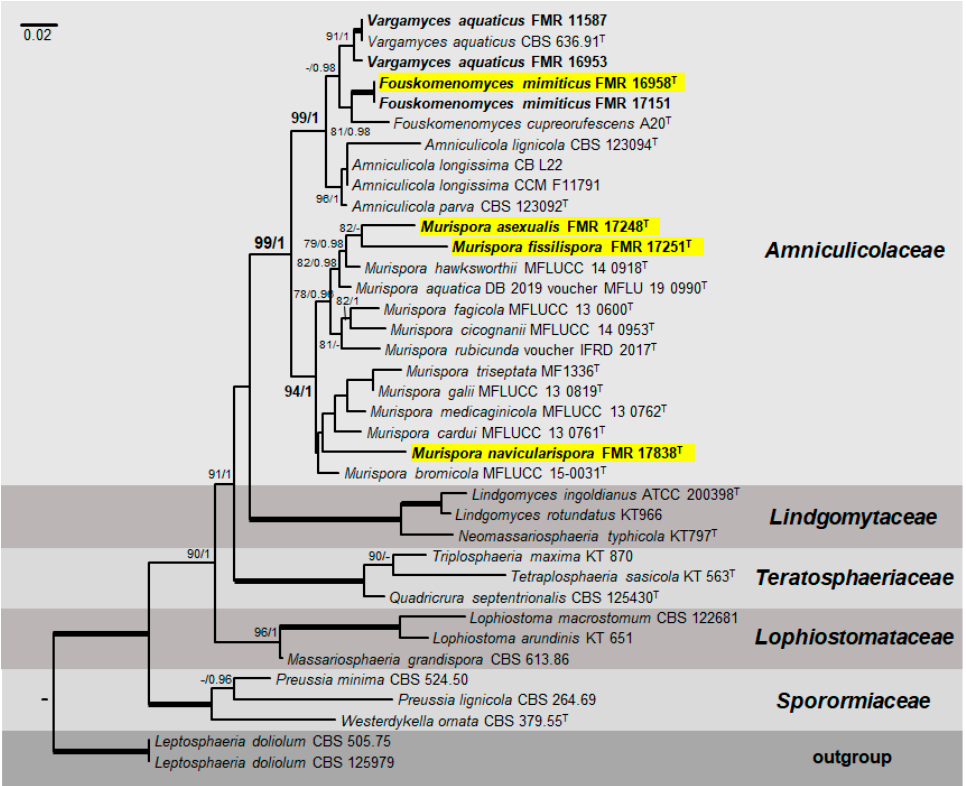
Figure 1. Phylogenetic tree inferred from a maximum likelihood analysis based on a concatenated alignment of D1-D2 domains of the 28S nrRNA gene ( LSU ), the internal transcribed spacer region (ITS) of the nrDNA, and a fragment of the translation elongation factor 1-alpha ( tef1 ) gene sequences of 37 strains representing species in Amniculicolaceae, Lindgomytaceae, Lophiostomataceae, Sporormiaceae and Teratosphaeriaceae. The Bayesian posterior probabilities (PP) above 0.95 and the RAxML bootstrap support values (BS) above 70% are given at the nodes (PP/BS). Fully supported branches (1 PP/100 BS) are indicated in bold. Strains isolated during the developing of this work are in bold. Newly proposed taxa are highlighted in a yellow background. Type strains are indicated by a superscript “T”. The tree was rooted with Leptosphaeria dolium (CBS 125,979 and CBS 505.75). Alignment length 1,936 bp.